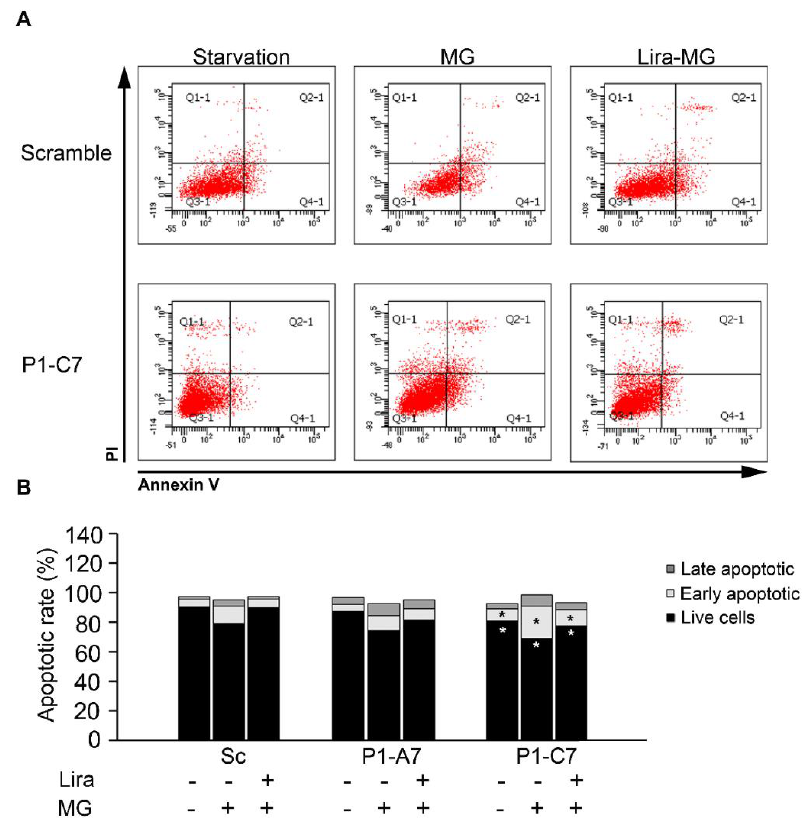
Figure 8. Lira treatment alleviated toxic e ff ect of MG. Apoptotic rate was measured in cells treated with or without 100 nM Lira for 5 h and then treated with / without 600 µ M MG for 24 h and cytometry. ( A ) Representative dot plots of annexin V-FITC binding and PI uptake of scramble and P1-C7 KD clone in the three experimental conditions. ( B ) The bar chart depicts the percent distribution of alive (intact), early- and late-apoptotic cells. The percentage of annexin V-positive cells obtained from three separate experiments. Results are expressed as mean values. * p < 0.05 vs.